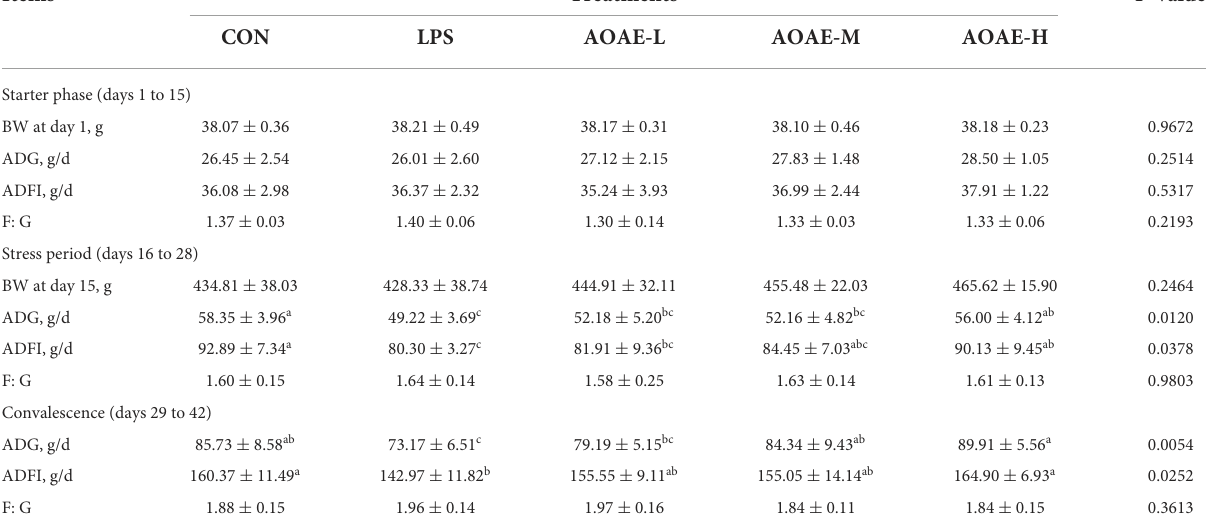
TABLE 3 Effect of AOAE on growth performance of broilers challenged with